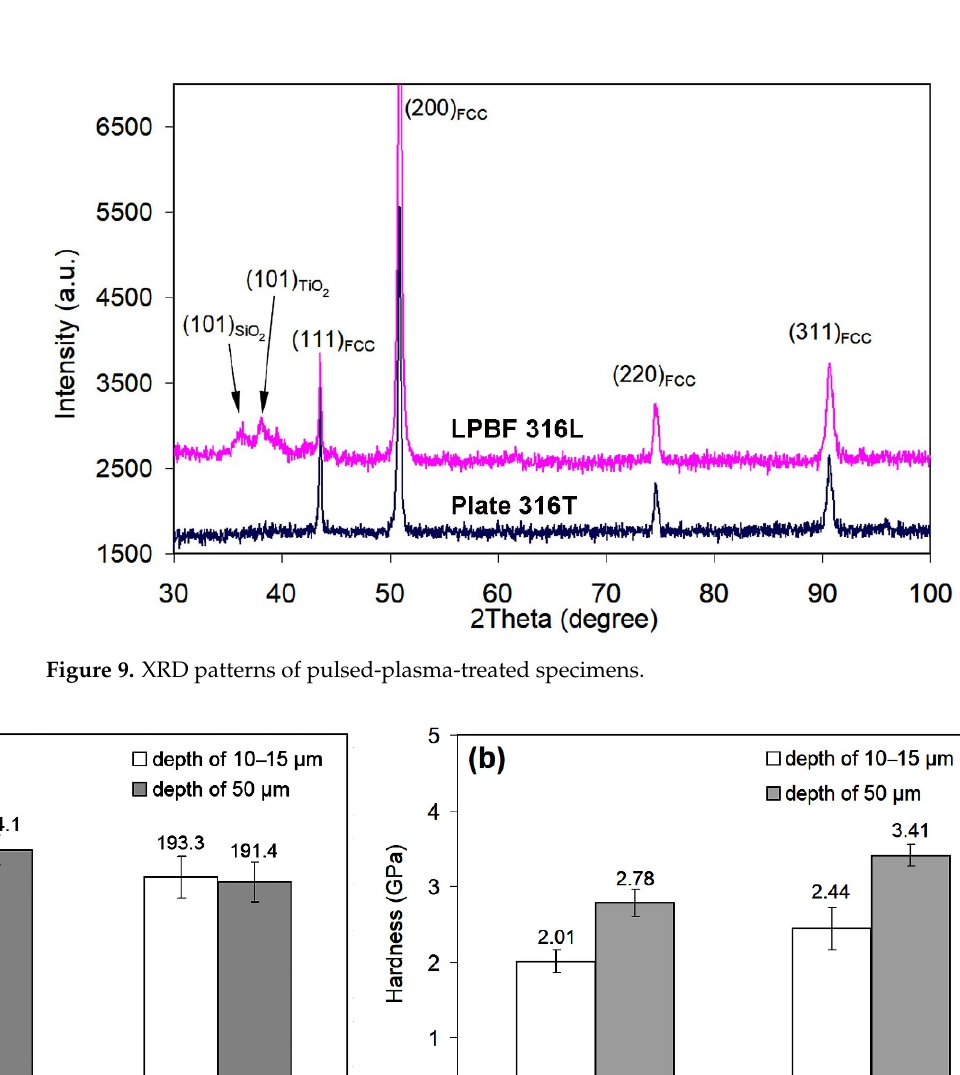
Figure 10. Nanoindentation response of the pulsed-plasma-modified specimens at different depth: ( a ) elastic modulus, ( b ) hardness.